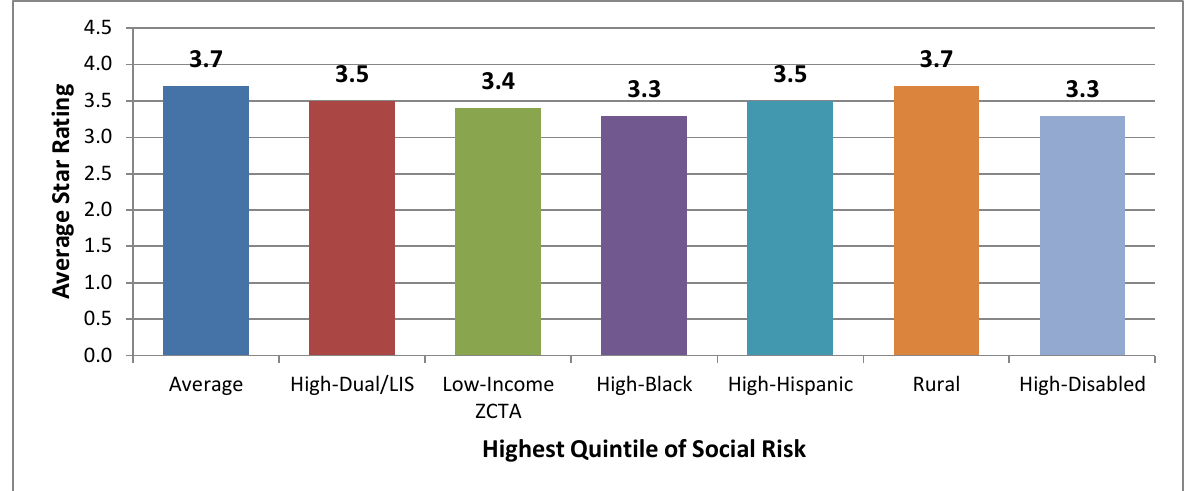
Figure 8.3: Contract Social Risk and Quality Star Rating